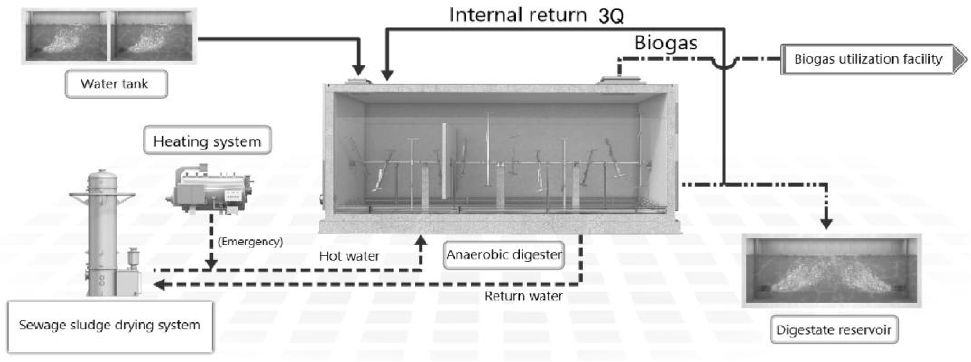
Figure 4. Anaerobic digestion system. From reference [30].